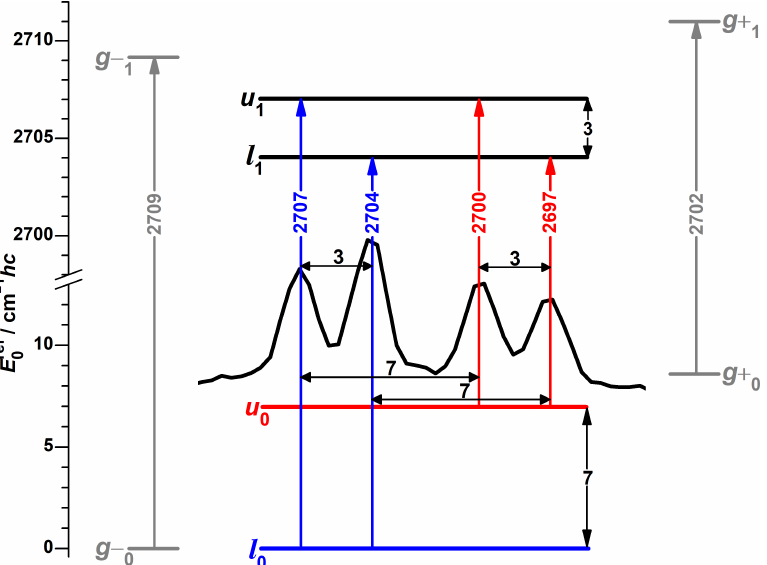
Figure 6. Raman spectral pattern in the OD stretching spectrum of α -fenchol with repeating sepa- rations (black horizontal double-headed arrows) translated into torsional splittings (black vertical double-headed arrows). The ground state l 0 and transitions originating from it are colored blue, for the first excited torsional state u 0 likewise red, for hypothetical localized g − and g + states gray, the latter based on DLPNO-CCSD(T)/aug-cc-pVQZ//PBE0-D3(BJ)/may-cc-pVTZ calculations with shifted harmonic OD stretching wavenumbers [51]. l stands for lower and u for torsional upper state, the index 0 or 1 indicates the OD stretch quantum